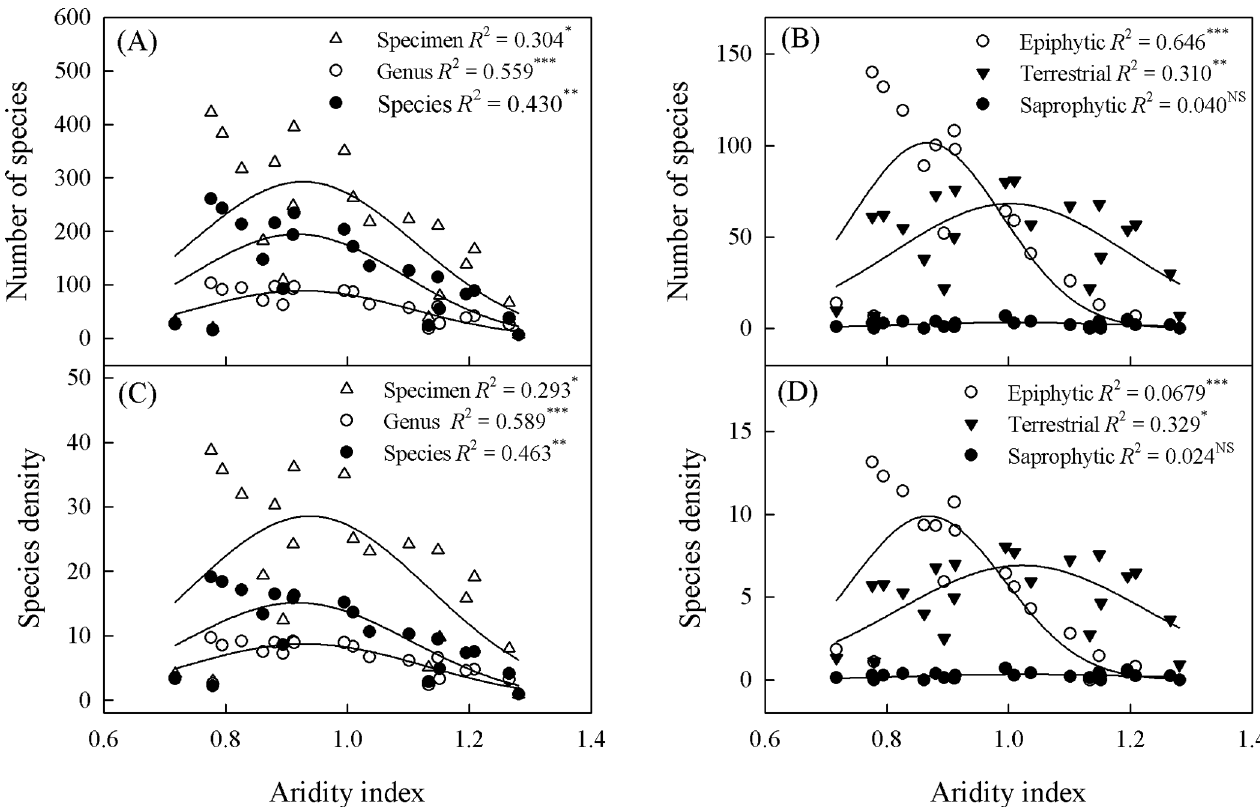
Fig 9. Variations in orchid species richness (SR, panel A-B) and speciesdensity (SD, panel C-D) as function of aridity index (AI). (A) Specimen: SR = -7915.83 + 23390.57 * AI − 21631.42 * AI 2 + 6422.12 * AI 3 ; Genus: SR = -2583.24 + 7696.96 * AI − 7211.44 * AI 2 + 2176.77 * AI 3 ; Species: SR = -457.22